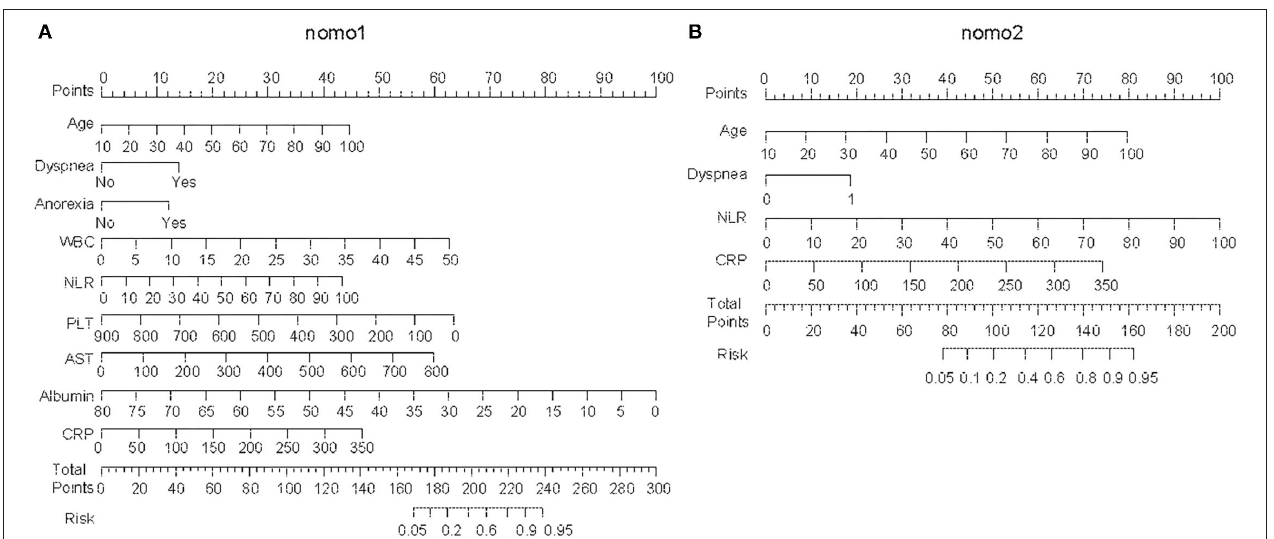
Frontiers in Medicine |